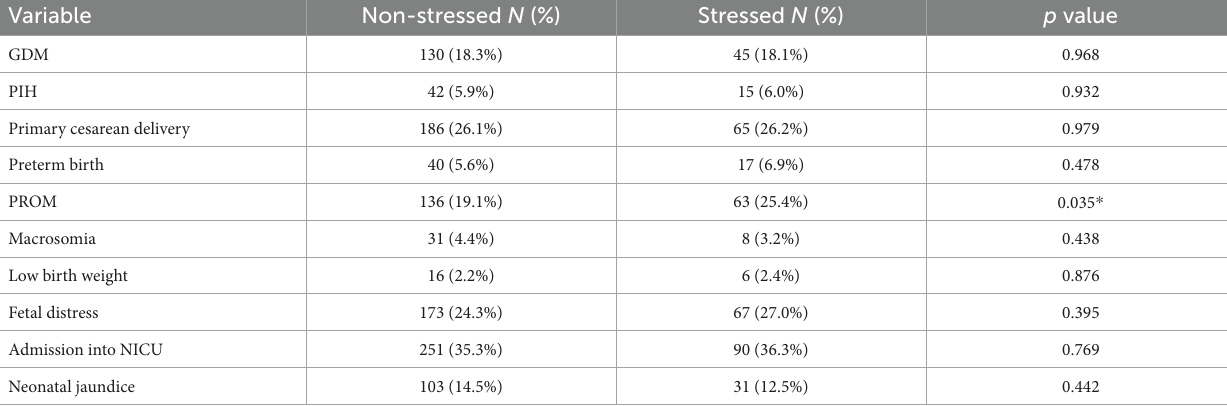
TABLE 2 Descriptive statistics between maternal second-trimester stress and pregnancy complications and pregnancy